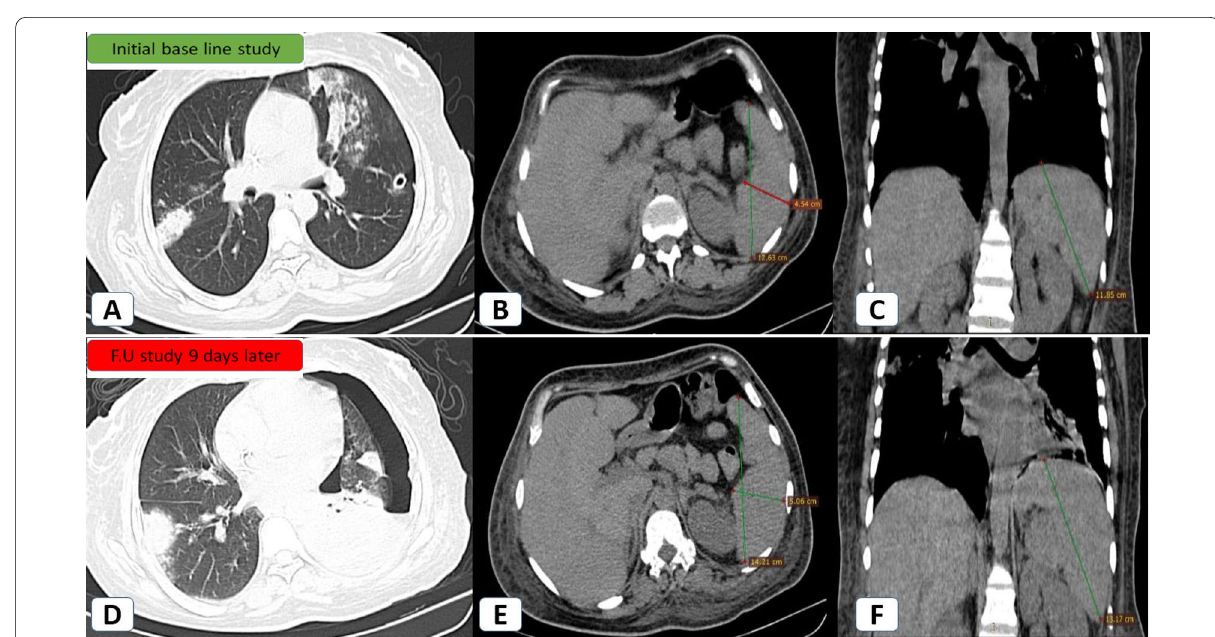
Fig. 5 Progressive splenomegaly in a 43-year-old female patient with severe COVID-19 infection and elevated Interleukin-6 (320 pg/ml), consistent with initiation of cytokine storm: A – C Initial baseline study: A Axial HRCT (lung window) showing right posterior segmental upper lobar sub-pleural ground glass patch and left upper lobar confluent ground opacities. Minimal left-sided pneumothorax was noted with an inserted inter-costal tube. B Axial CT (mediastinal window) for the maximum anteroposterior and side-to-side splenic dimensions (12.6 cm and 4.5 cm). C Coronal CT (mediastinal window) for the maximum splenic craniocaudal dimension (11.8 cm). D – F Follow-up of the same patient nine days later: D Axial HRCT (lung window) showing left-sided progressing hydro-pneumothorax with denovo left lingular sub-pleural wedge-shaped patch. E Axial CT (mediastinal window) for the maximum anteroposterior and side-to-side dimensions (14.2 cm and 5 cm). F Coronal CT (mediastinal window) for the maximum craniocaudal dimension (13.1